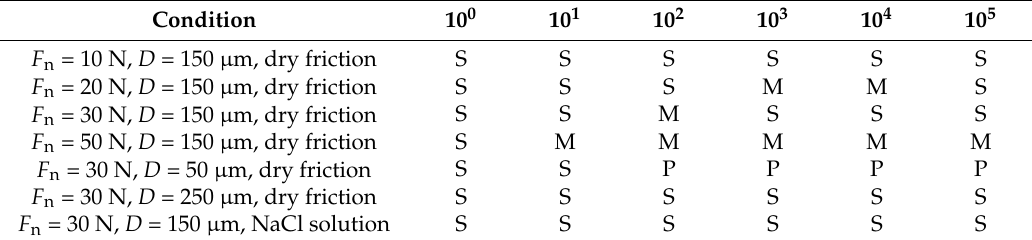
Table 1. Distribution of fretting regimes of Al wires. F n : contact loads; D : displacement amplitude Condition